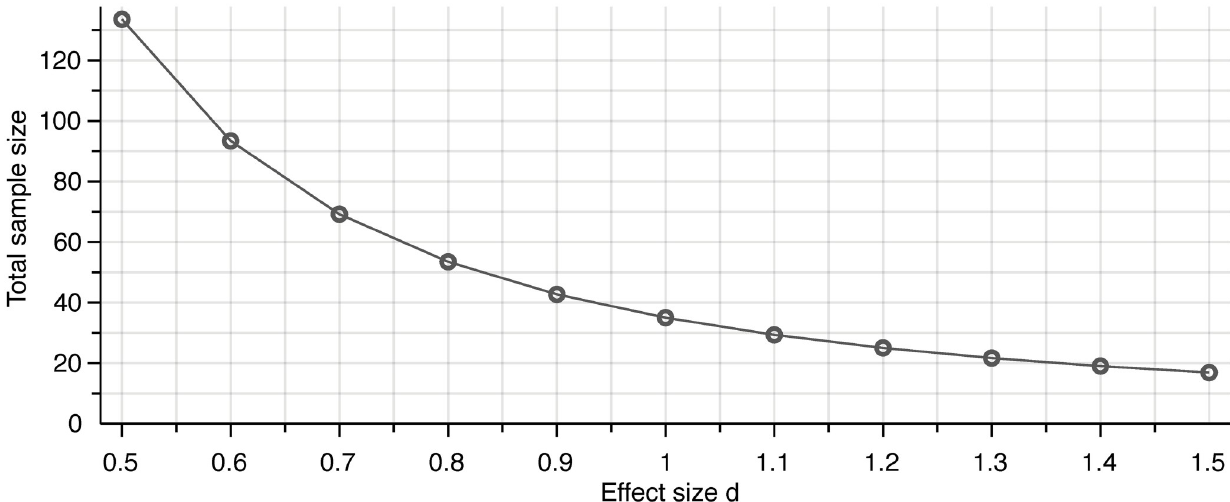
PLOS ONE | https://doi.org/10.1371/journal.pone.0252493 June 4,